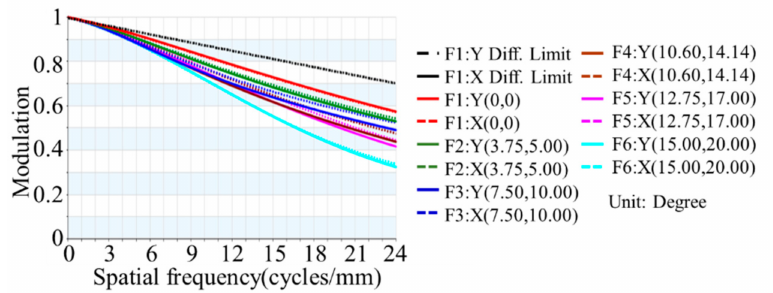
Figure 6. Modulation Transfer Function (MTF) chart in aspherical system.